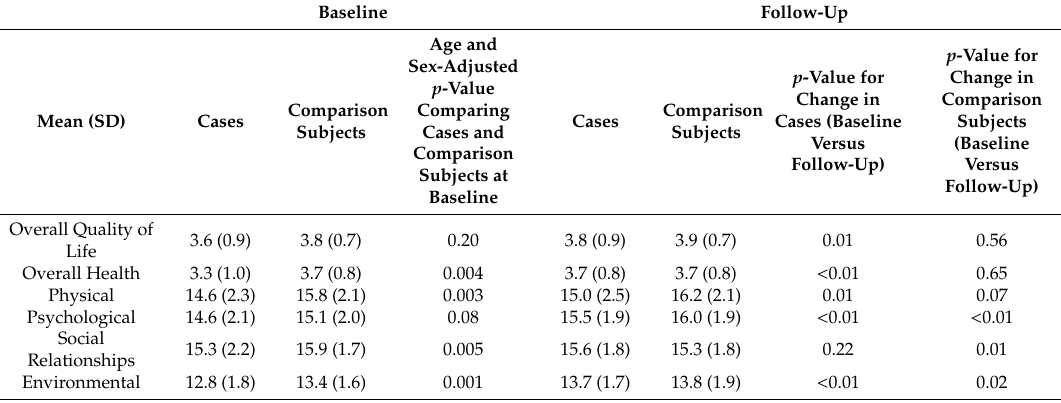
Table 5. Quality of life of cases and comparison subjects, at baseline and